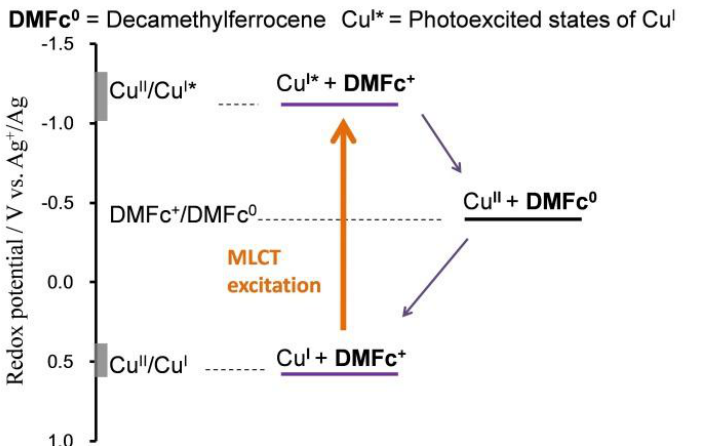
Figure 8. Diagram for the redox potentials of 1  BF and DMFc +